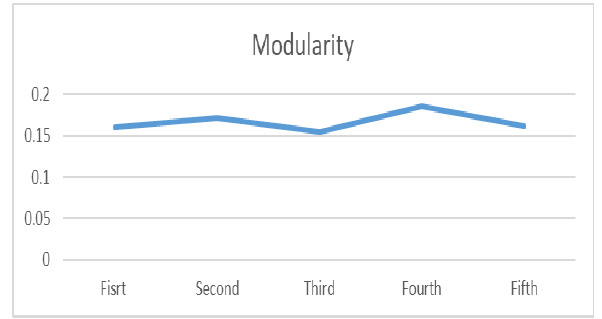
Figure 16. Network Modularity for network graph after